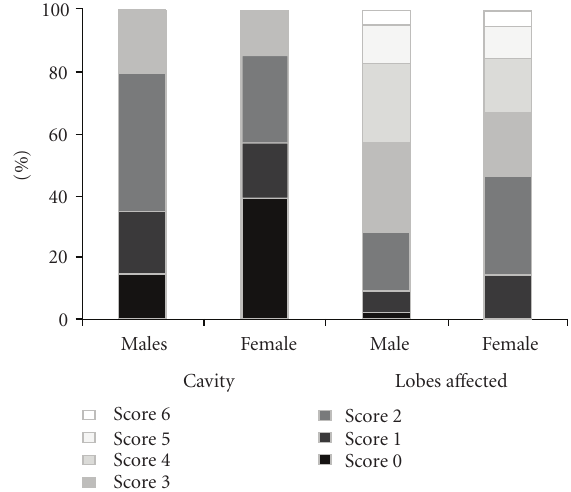
Figure 2: X-ray cavity and area a ff ected scores of culture positive TB cases by